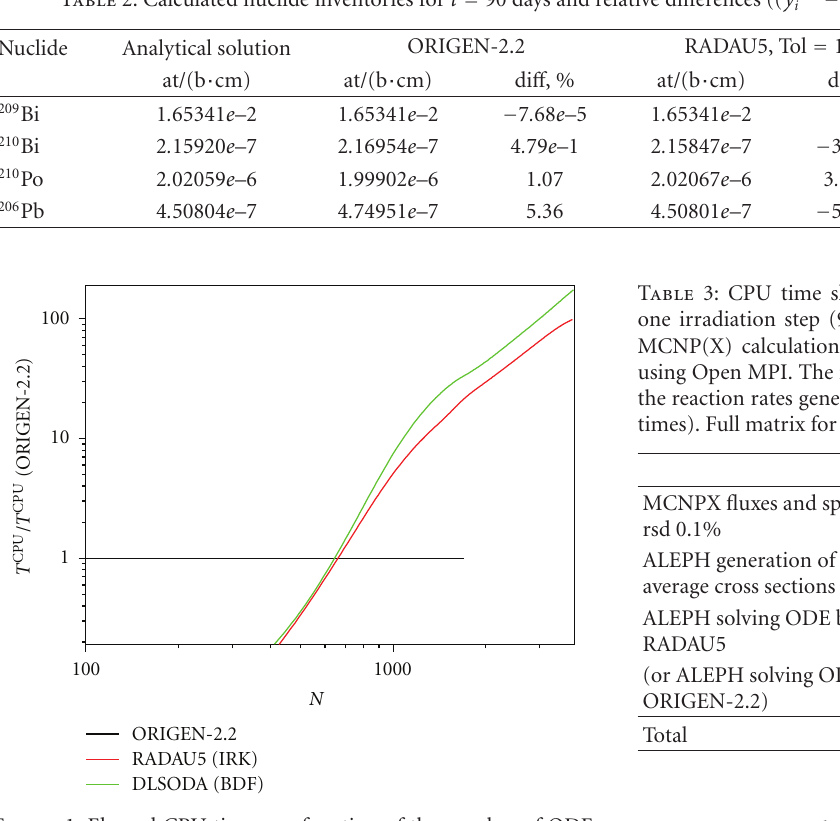
Table 2: Calculated nuclide inventories for t = 90 days and relative di ff erences (( y calc